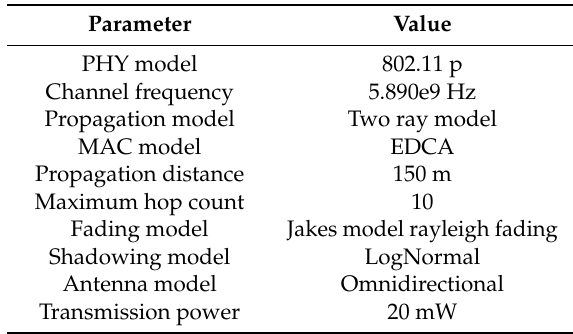
Table 5. Wireless Communication Parameter.